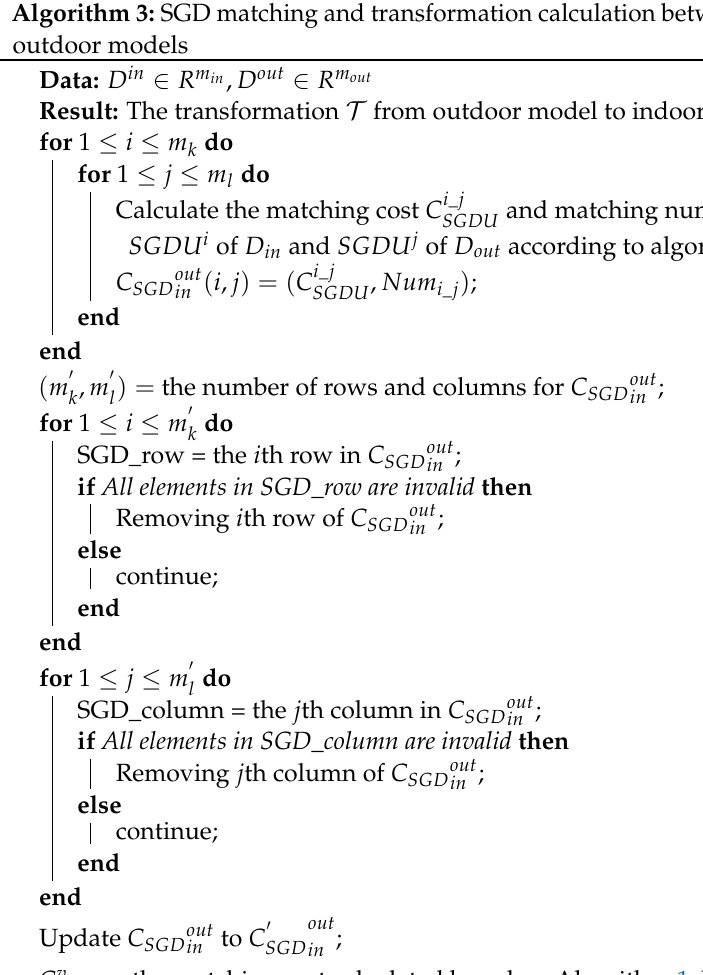
Algorithm 3: SGD matching and transformation calculation between indoor and outdoor